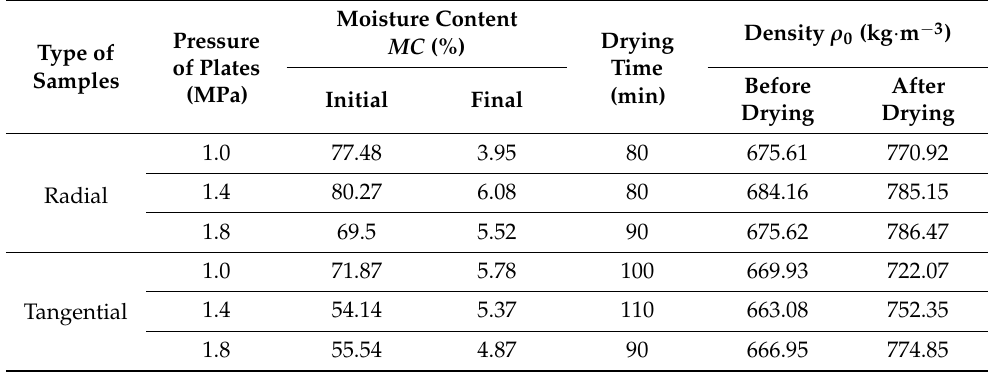
Table 1. Initial and final moisture content of the samples, drying time and density of the samples. Type of